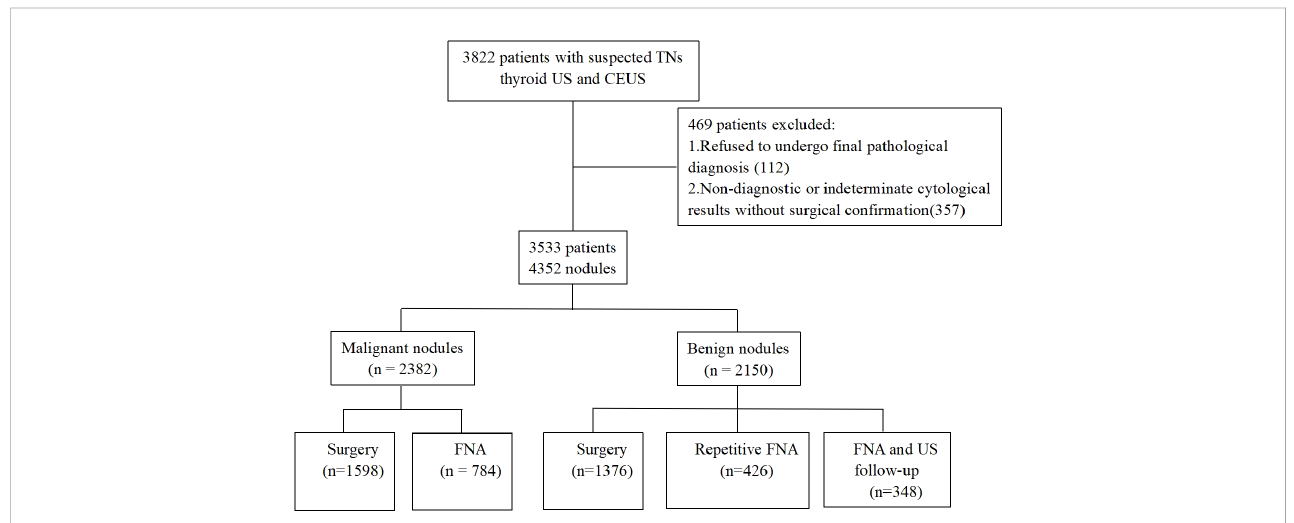
FIGURE 1 Flow chart of the study population. TNs, thyroid nodules; US, ultrasound; CEUS, contrast-enhanced ultrasound; FNA, fi ne needle